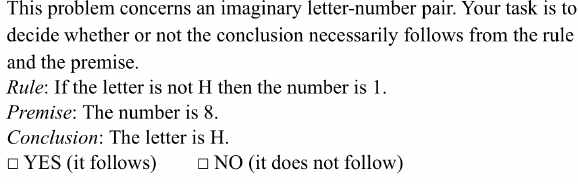
Figure 1. Four indicative items from the Conditional Inference Task (adapted from [ 19 ] ). The problems ask about a) the modus